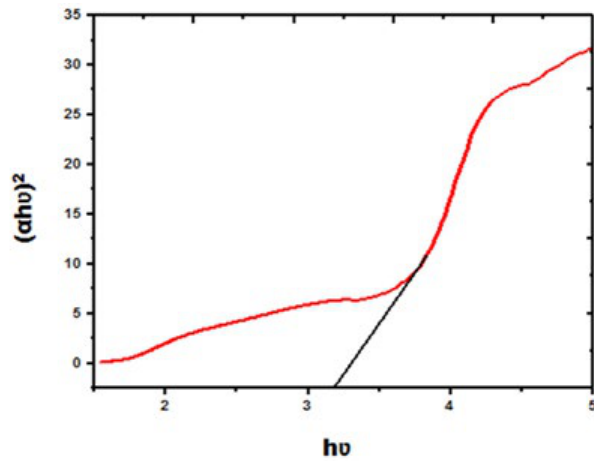
Fig. 5. UV-Vis DRS spectrum of the synthesized CeVO Fig. 5 UV-Vis DRS spectrum of the synthesized CeVO 4 NPs